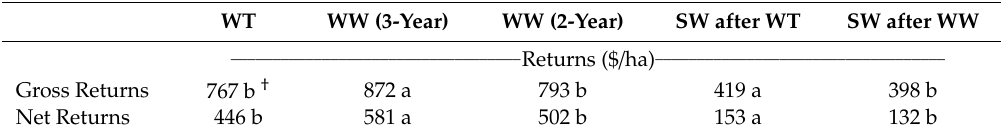
Table 7. Gross returns and net returns for winter triticale (WT), 3-year and 2-year winter wheat (WW), spring wheat (SW) after WT, and SW after WW averaged over eight years (2012–2019). Costs for fallow were included in the net returns for the winter crops, so returns for the crops represent the returns over two